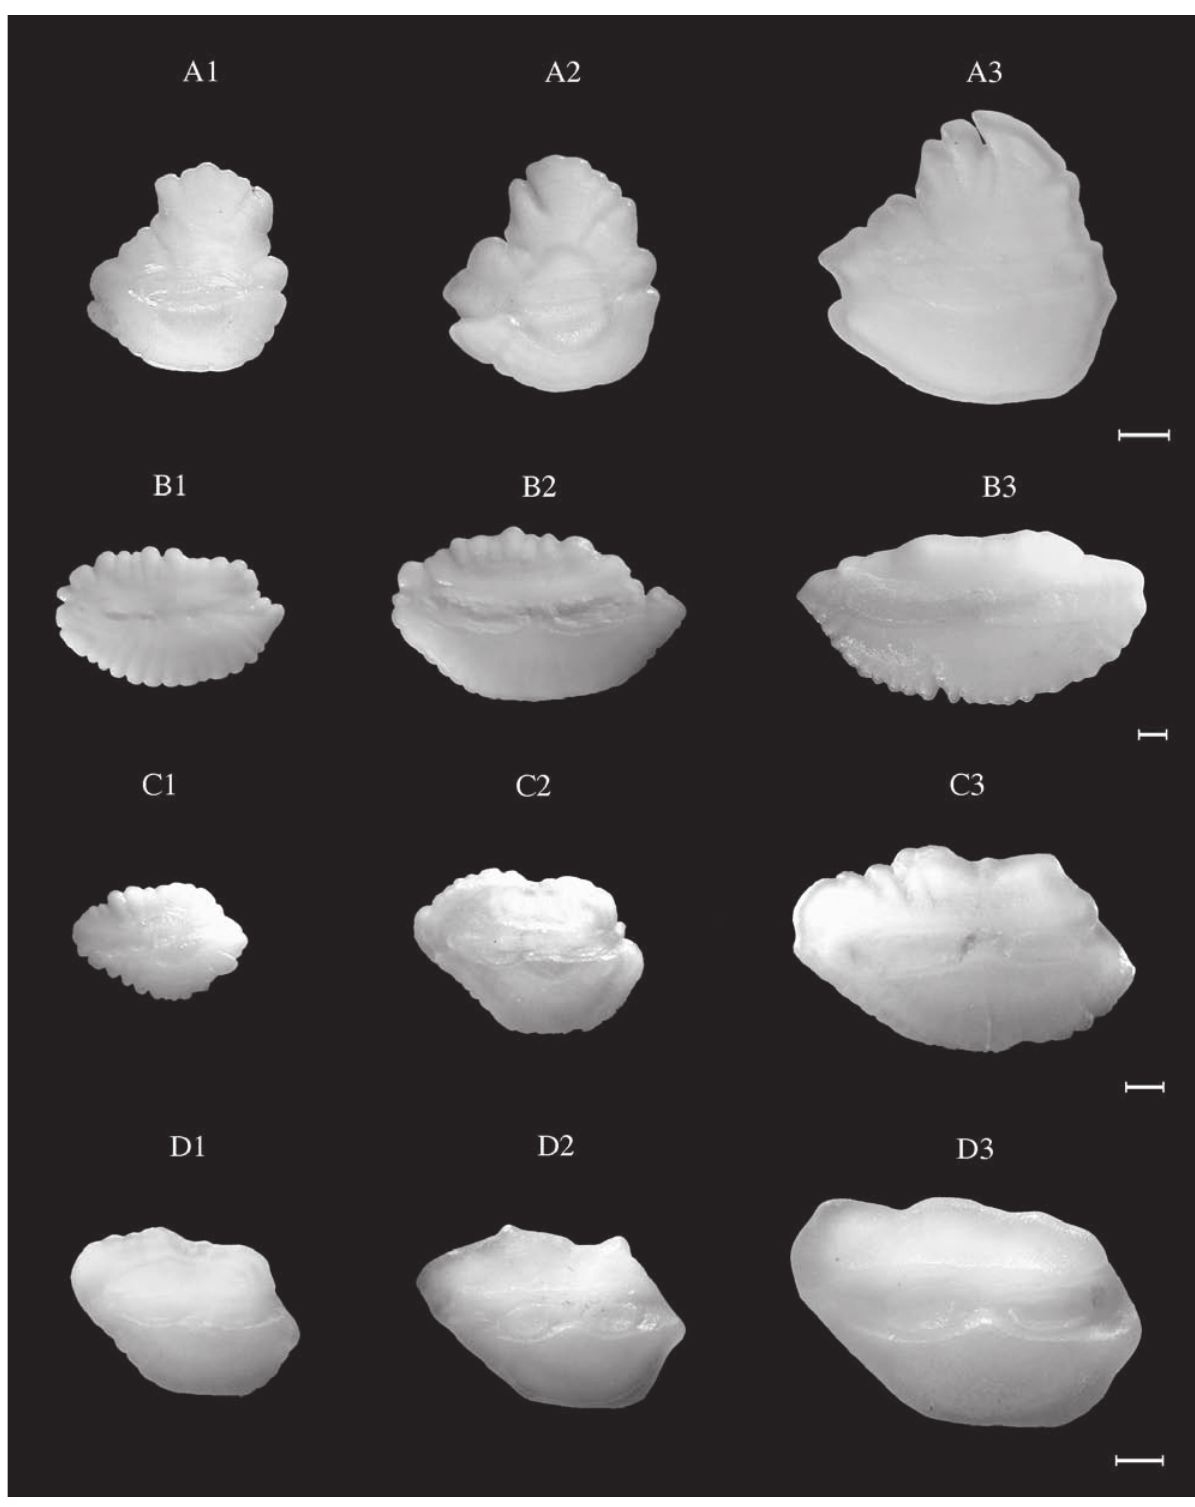
Fig. 26. – Hymenocephalus italicus . PL: A1, 2.5 cm (WM); A2, 3.4 cm (NEA); A3, 4.9 cm (NEA). Malacocephalus laevis . PL: B1, 4.6 cm (NEA); B2, 6.9 cm (NEA); B3, 10.1 cm (CEA). Nezumia aequalis (WM). PL: C1, 2.5 cm; C2, 4.0 cm; C3, 5.5 cm. Nezumia sclerorhynchus (NEA). PL: D1, 2.0 cm; D2, 4.1 cm (WM); D3, 6.3 cm (NEA). Scale bar = 1